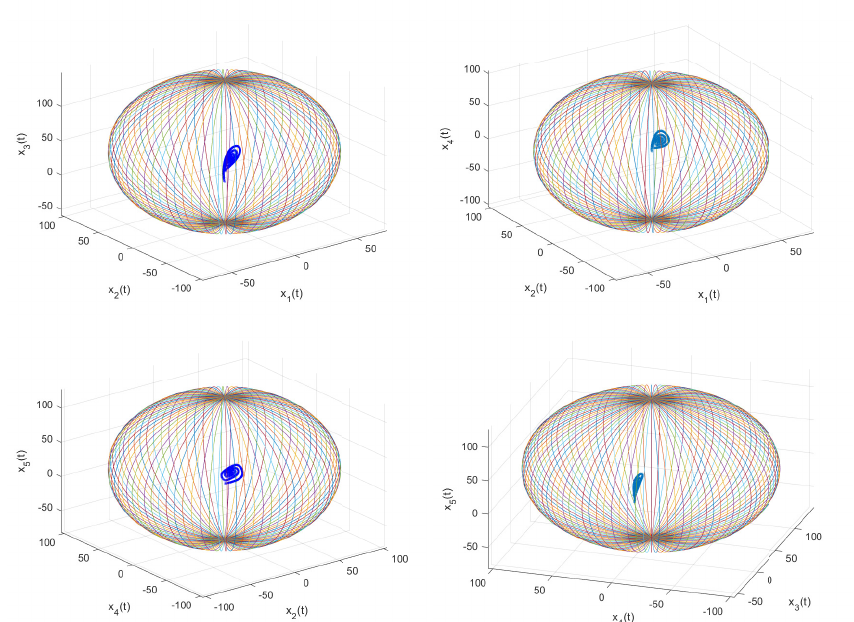
) of system (13), where σ = 10, b = 8 U 2,1